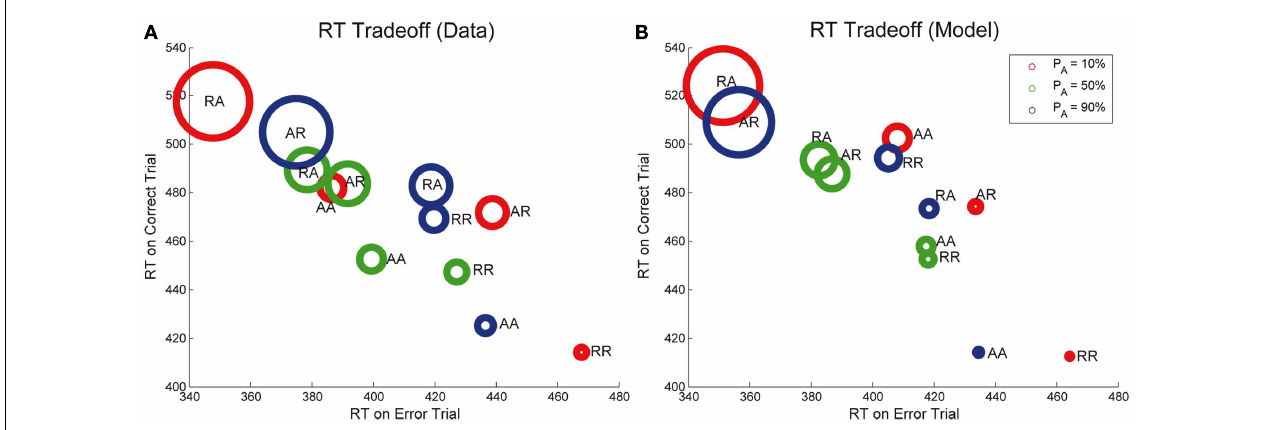
FIGURE 8 | Sequential RT tradeoff for Experiment 2. Mean RTs for correct trials are strongly correlated with mean RTs for error trials for each of the sequences RR, AR, RA, AA, for each value of P A for both (A) data and (B) adapted DDM.